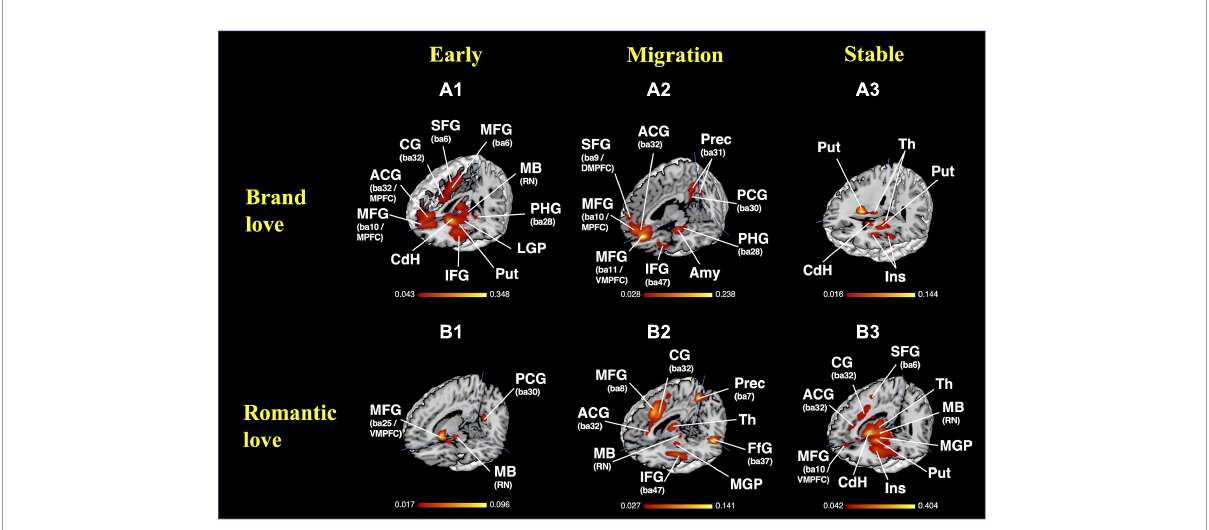
FIGURE7 Results of the MACM. (A) Brand love relationships; (A1) early stage, crosshair = (0, − 34, − 6); (A2) migration stage, crosshair = (4, − 64, − 16); (A3) stable stage, crosshair = (28, − 40, 2); (B) interpersonal romantic love relationships; (B1) early stage, crosshair = (10, − 60, − 14), (B2) migration stage, crosshair = (6, − 62, − 8); (B3) stable stage, crosshair = (6, − 62, − 8). MACM, meta-analytical connectivity modeling; BA, brodmann area; ACG, anterior cingulate gyrus; Amy, amygdala; CG, cingulate gyrus; CdH, caudate head; DMPFC, dorsomedial prefrontal cortex; FfG, fusiform gyrus; IFG, inferior frontal gyrus; Ins, insula; LGP, lateral globus pallidum; MB, midbrain; MFG, medial frontal gyrus; MGP, medial globus pallidum; MPFC, medial prefrontal cortex; PCG, posterior cingulate gyrus; PHG, parahippocampal gyrus; PreCG, precentral gyrus; Prec, precuneus; Put, putamen; RN, red nucleus; SFG, superior frontal gyrus; Th, thalamus; VMPFC, ventral medial prefrontal